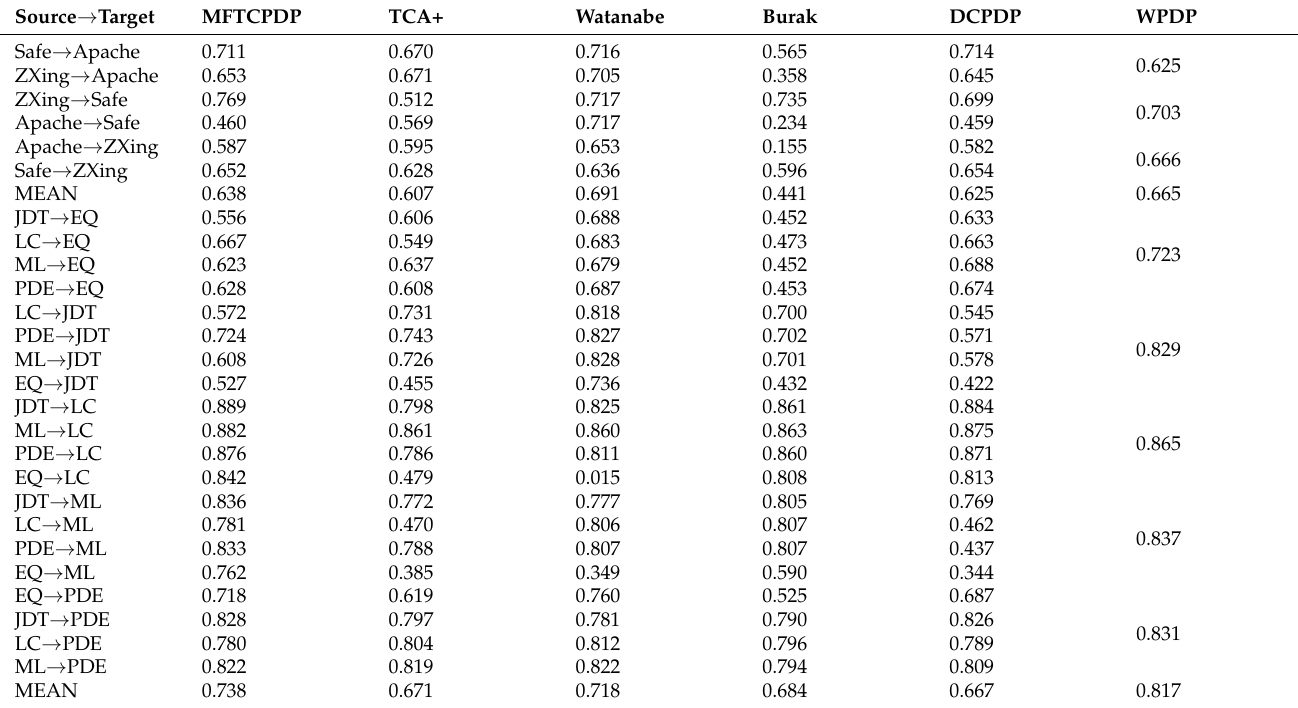
Table 3. Comparison of F1 value between MFTCPDP and several CPDP methods and